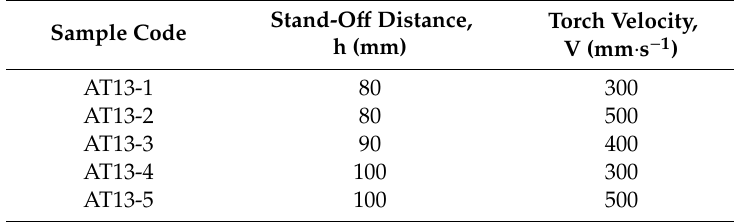
Table 1. Sample codes and atmospheric plasma spraying (APS) process